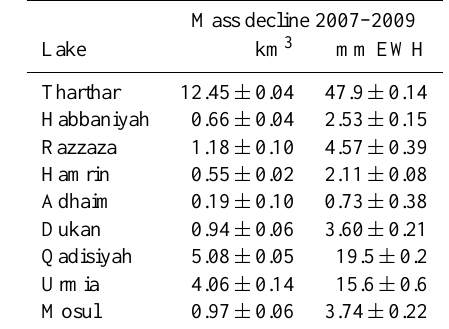
Table 2. Oversight of water mass decline of lakes within the ex- tended study area in km 3 andmm EWH. Note that the mass decline of Lake Urmia and Lake Razzaza is part of a more gradual mass de- cline, while the water mass decline of other lakes mainly occurred during the 2007–2009 drought due to lake